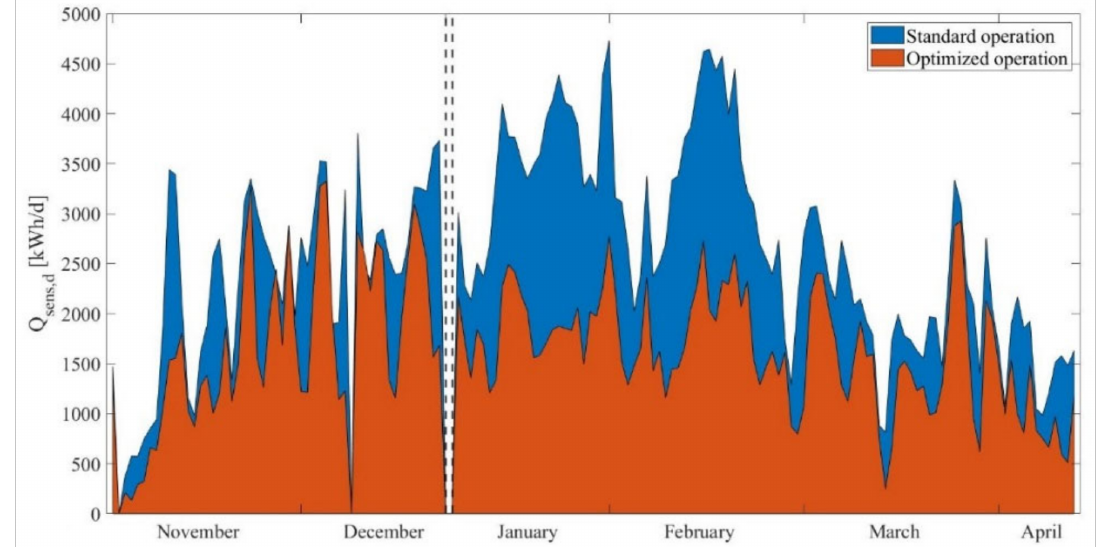
Figure 10. Evolution of the daily heating demand according to the “standard” and the “optimized” controls.